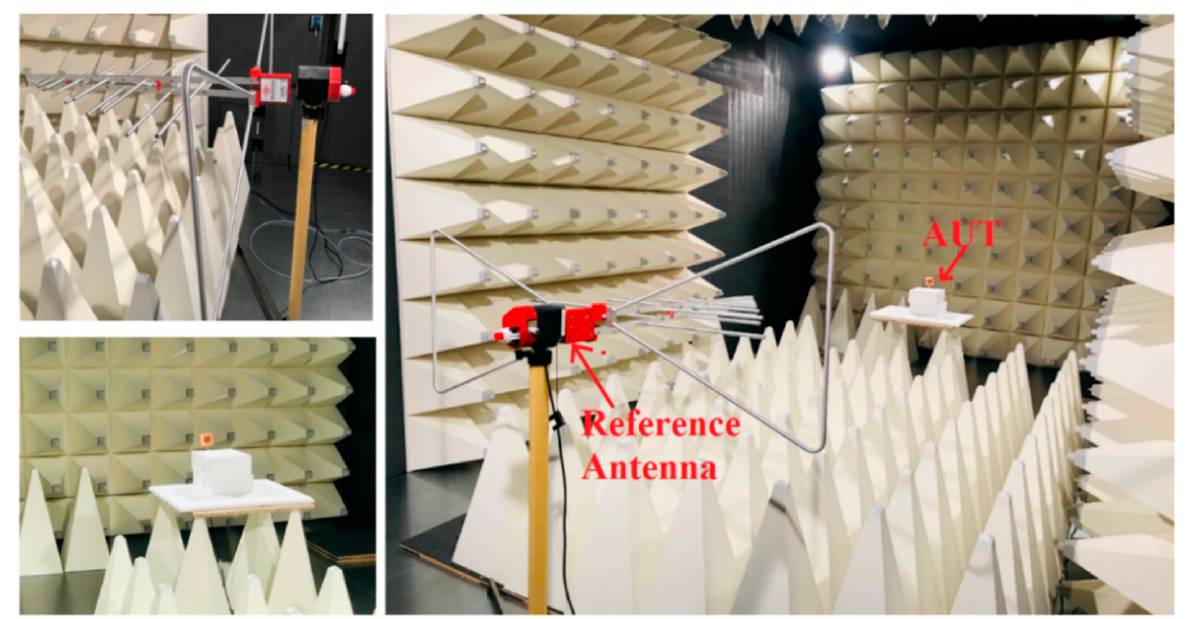
Figure 8. Testing arrangements in the Frankonia anechoic chamber.